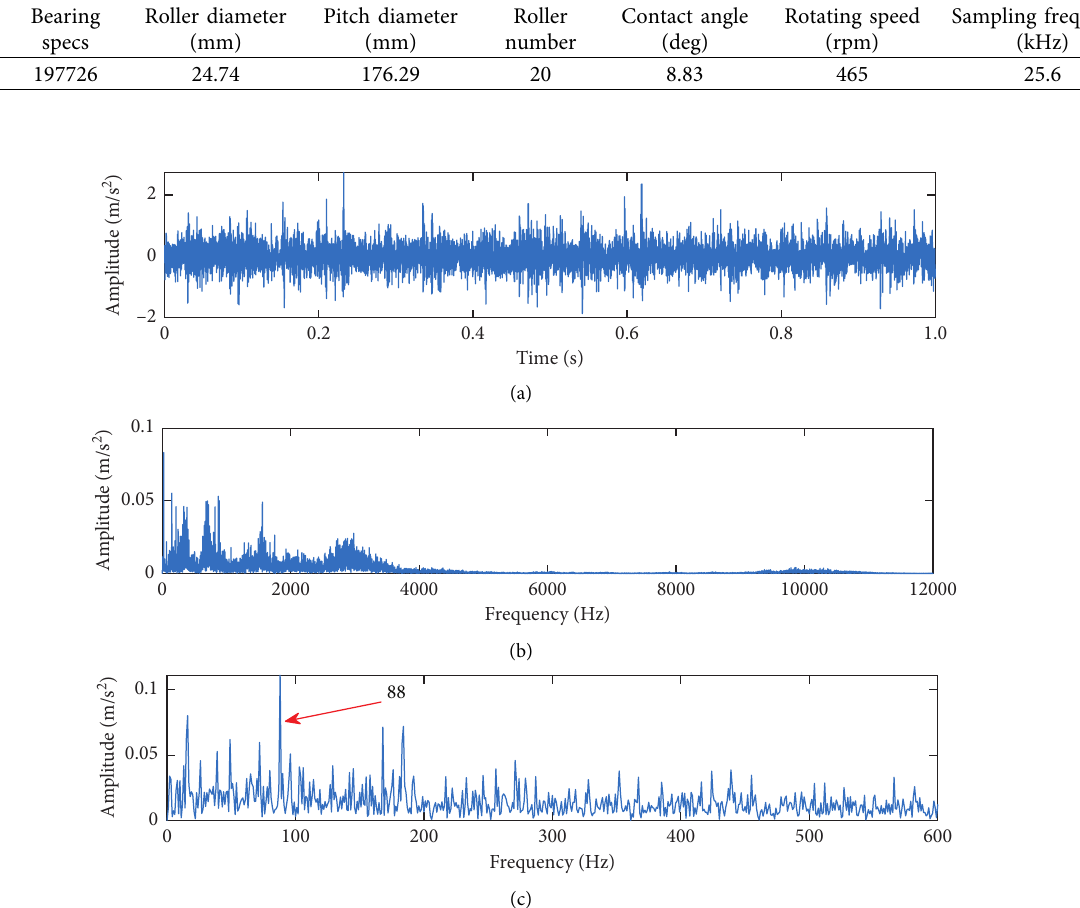
Figure 25: Experimental signals of case 2: (a) time-domain waveform, (b) frequency spectrum, and (c) squared envelope